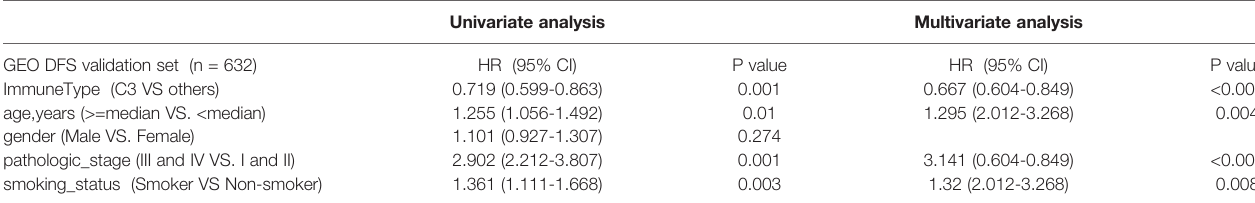
TABLE 3 | Univariate and multivariate Cox analyses of risk factors for DFS prediction in 4 GEO LUAD cohorts. Univariate